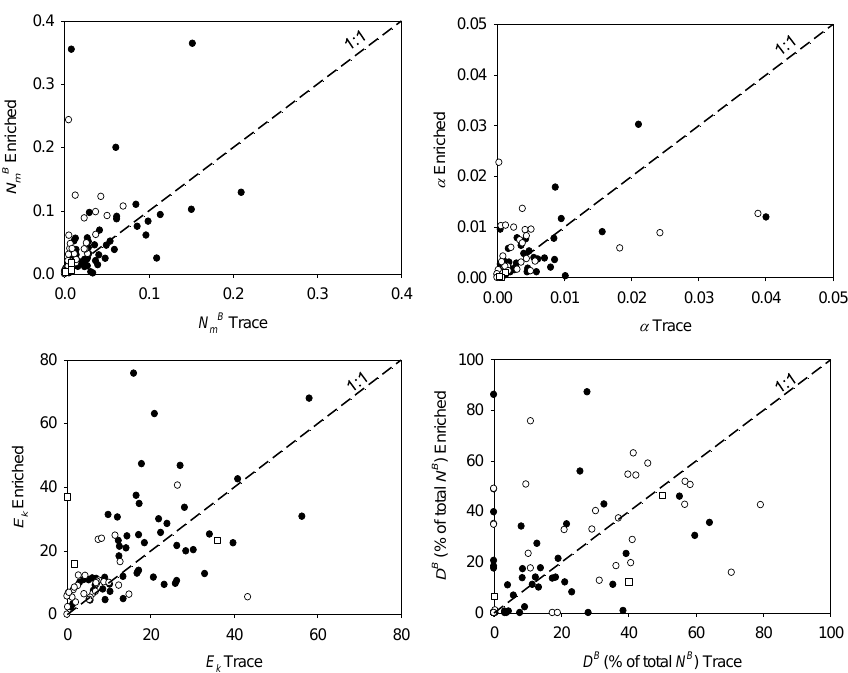
Fig. 9. Response of N B m , α , E k and D B for NO − enrichment during incubations (see Methods). The dashed 1:1 line represents a lack of response and is provided for visual reference. To ease the comprehension, the standard error is not presented in the graph (refer to “Sensor calibrations and data transformations”